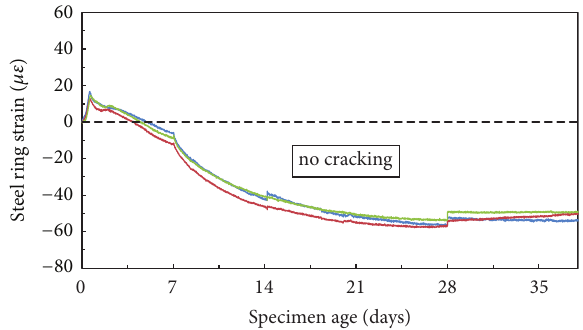
Figure 4: Restrained ring strain development over time for Mixture number 2. Each line denotes the average of four (4) strain readings for one ring. Three (3) rings were